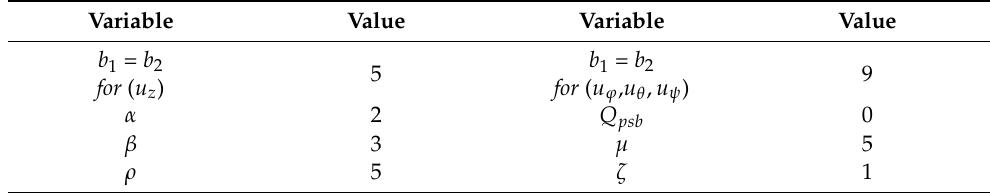
Table 1. Desired path and disturbances.